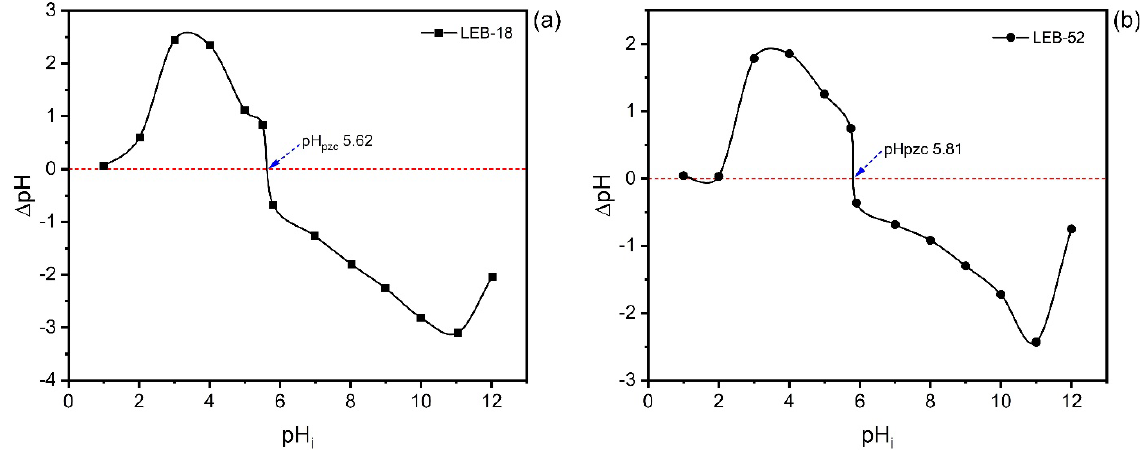
Figure 4. pHpzc of LEB− 18 ( a ) and LEB − 52 ( b ) biosorbents.